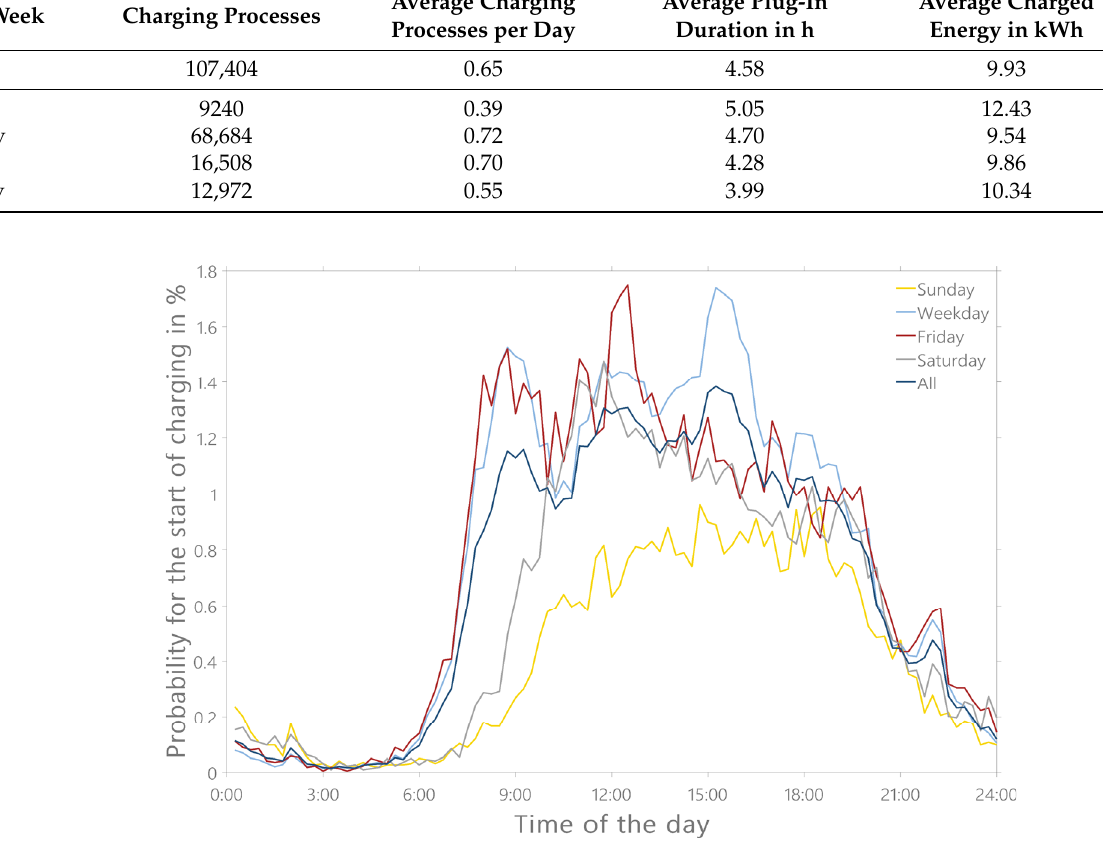
Figure 3. Probabilities for the start of a charging process classified by type-days in 15 min